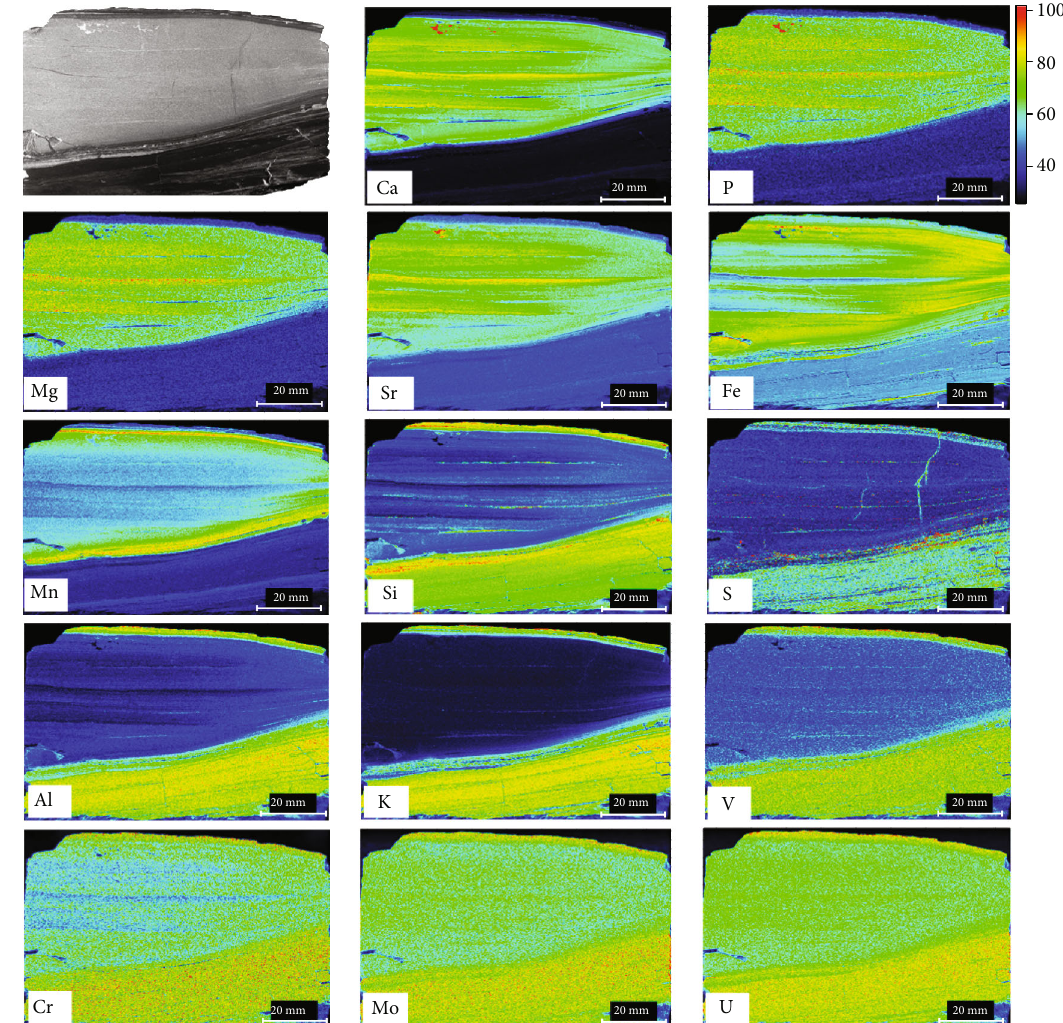
Figure 11: XRF elemental maps of dolomite nodule and host shale. Image size 101 × 76 : 5 mm ( 505 × 382 pixels); 200 μ m pixel size; 300 ms/ pixel. All images share the same color